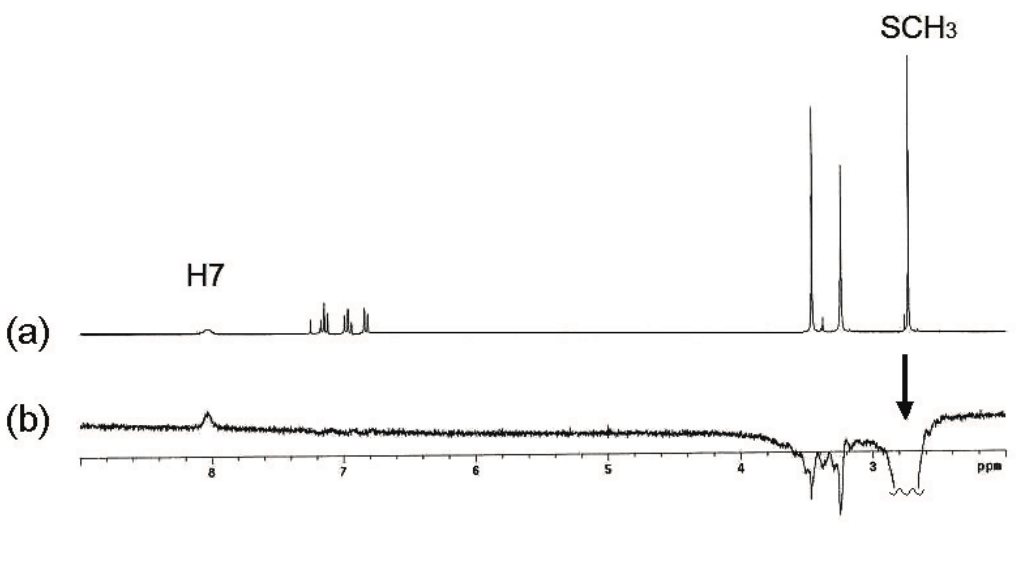
Figure 3. ( a ) 1 H-NMR spectrum of compound 12 in CDCl 3 ; ( b ) After irradiation of the SCH 3 signal, nOe on H7 was